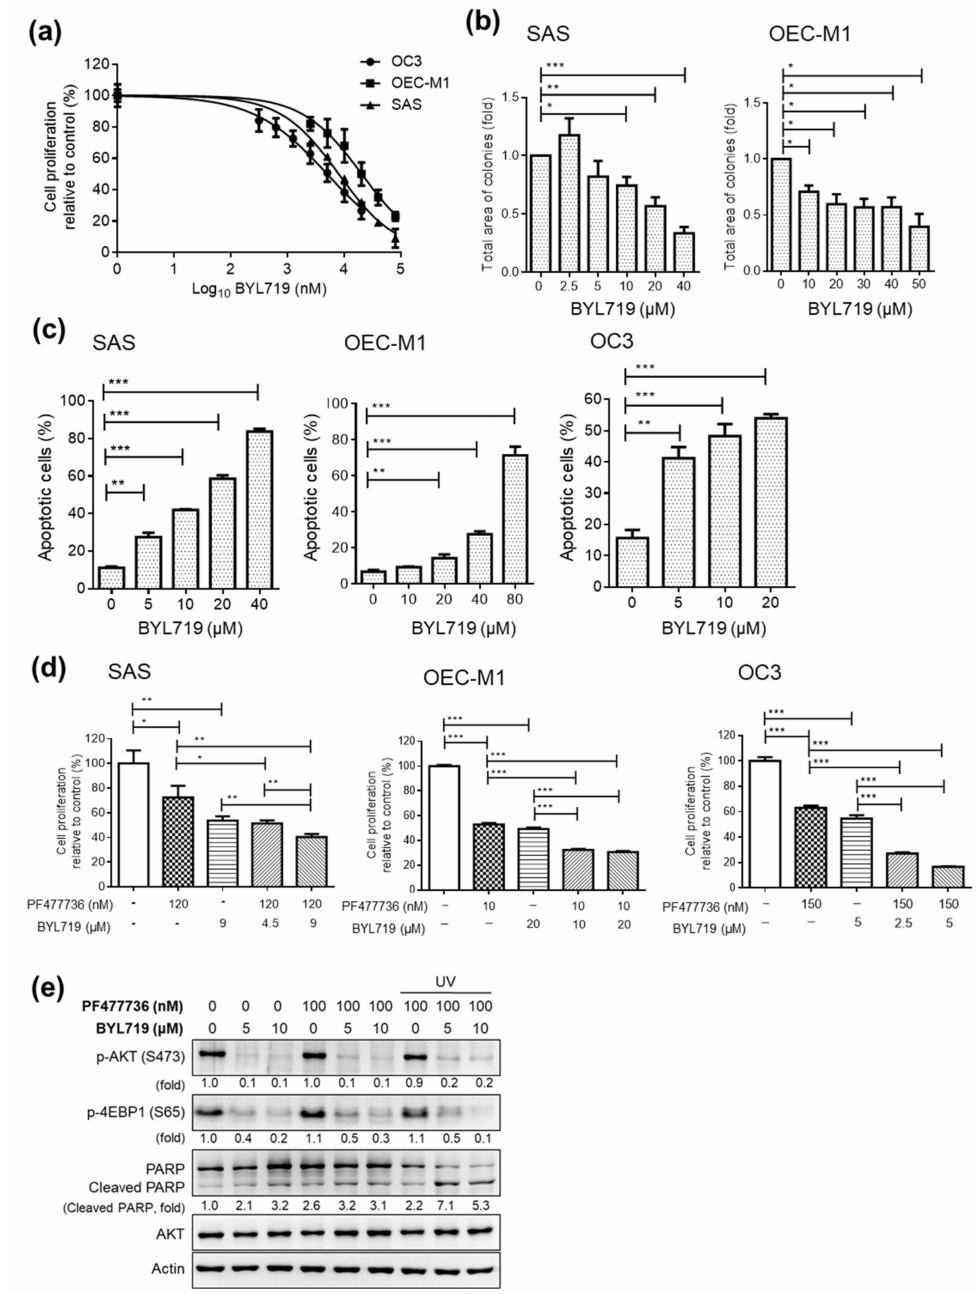
Figure 4. E ff ect of the PI3K inhibitor BYL719 alone and in combination with the CHK1 inhibitor PF477736 in OSCC cell lines. ( a ) Dose–response curve showing the cytotoxic e ff ect of treatment with the PI3K inhibitor (BYL719) for 48 h in SAS, OC3, and OEC-M1 cells, as assessed by MTT assays. A colony formation assay ( b ) and annexin V staining ( c ) were performed with OSCC cells treated with BYL719 at the indicated concentration. ( d ) Cells were treated with PF477736 plus BYL719 at the indicated concentrations for 48 h, and an MTT assay was then performed. The data were replicated in three independent experiments. The results are expressed as the mean ± SEM values. Statistical analysis of the di ff erences between two groups was performed with a t -test. * p < 0.05; ** p < 0.01; *** p < 0.001. ( e ) SAS cells seeded in 6-well plates were exposed to UV radiation (70 mJ / cm 2 ) for 2 h. Then, the cells were treated with the CHK1 inhibitor PF477736 and / or the PI3K inhibitor BYL719 at the indicated doses for another 2 h. Cell lysates were collected, and Western blot analysis was performed to assess the levels of p-AKT, p-4EBP1, PARP, and total AKT. Actin was used as the loading